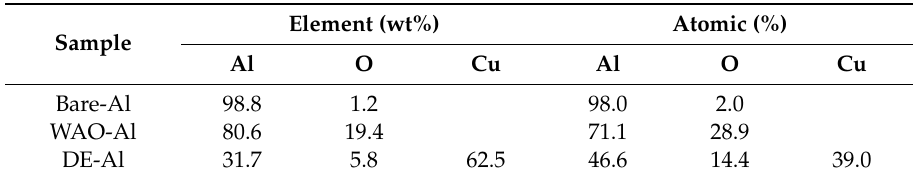
Table 1. Results of the energy-dispersive X-ray spectroscopy (EDS) analysis of three samples (Bare-Al, WAO-Al and DE-Al).